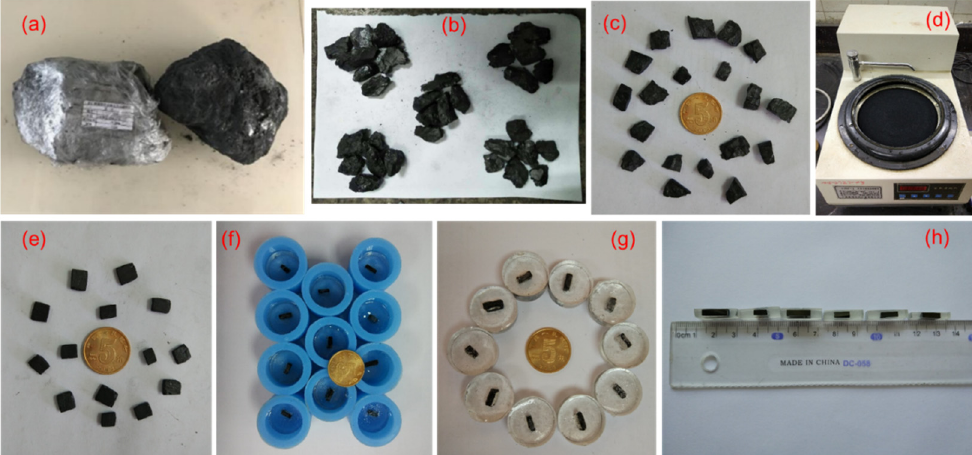
Figure 2. Process of sample preparation. ( a ) Block coal samples collected from the mine at one coal seam; ( b ) and ( c ) Irregular small coal samples obtained after breaking block coal sample; ( d ) YMP-1 grinding and polishing machine; ( e ) Regular small coal samples after polishing; ( f ) and ( g ) Small coal samples inlaid with epoxy resin and solidifying agent; ( h ) Regular small coal samples with 20 mm × 10 mm × 5 mm and evenly wrapped by the epoxy resin on both sides of the long side.